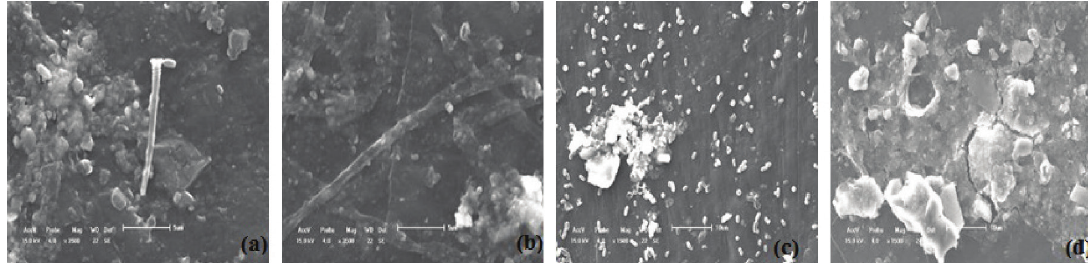
Figure 4. SEM micrographs of the surface of the PE and PE mixture of microorganism and (d) surface erosion.